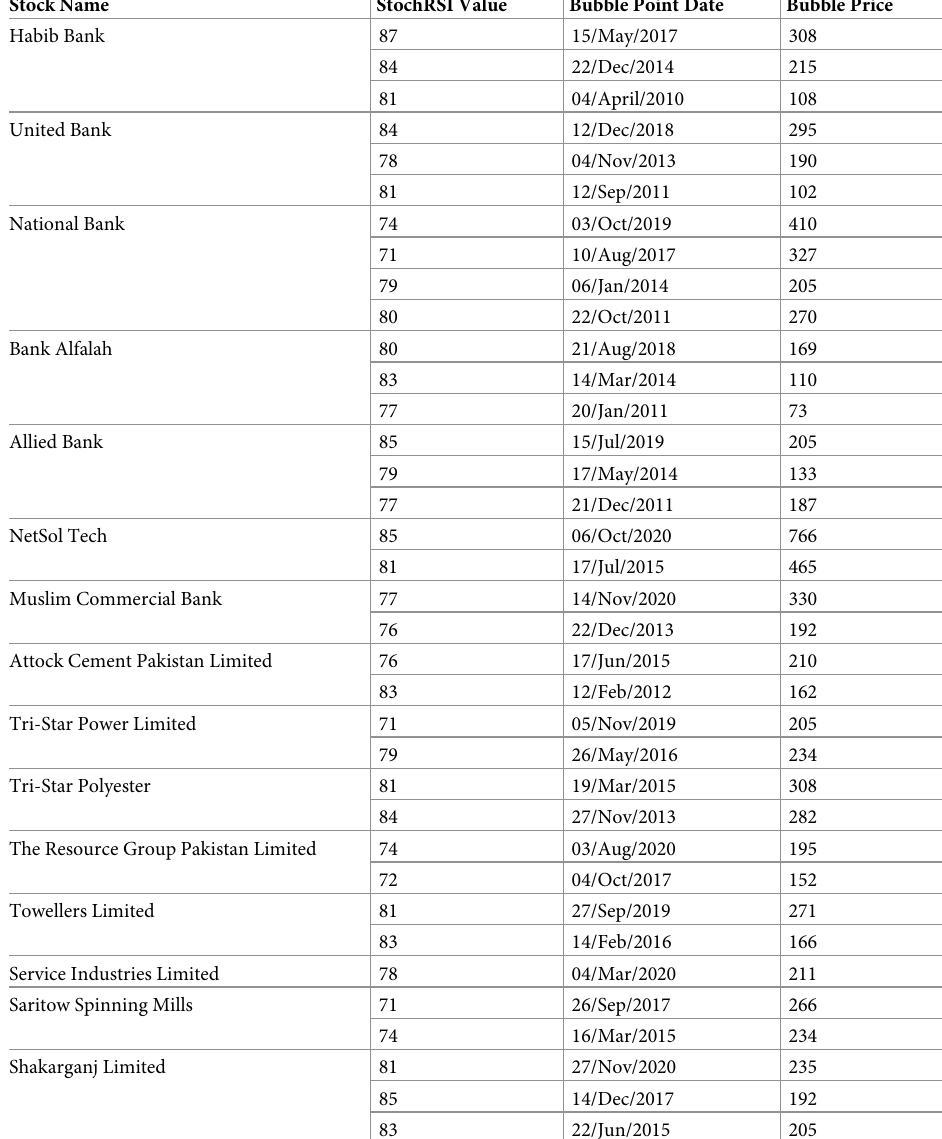
Table 2. StochRSI is used to identify stock price